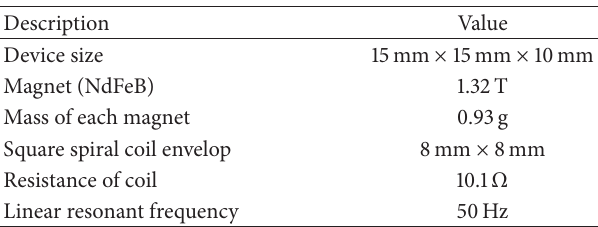
Table 3: Dimensions and parameters of the nonlinear EMEH prototype [28].